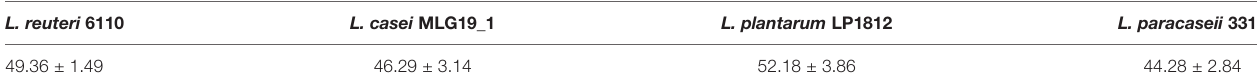
TABLE 1 | The contents of SCFAs in four Lactobacillus spp. supernatants (mmol/L). L. reuteri